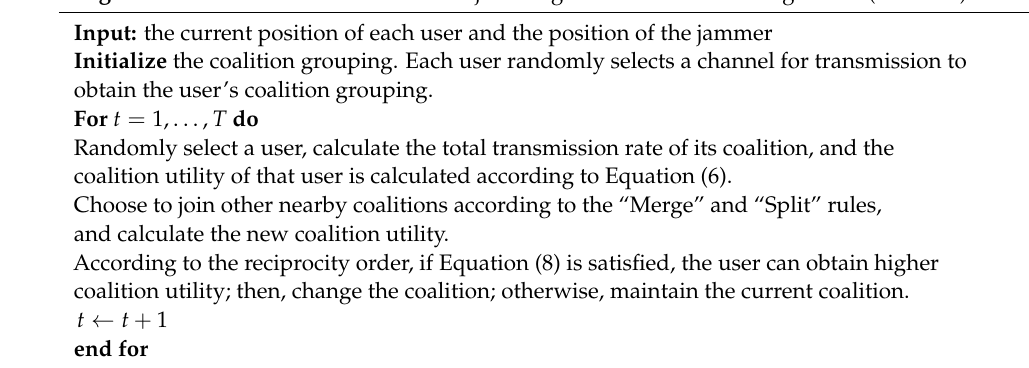
Algorithm 1 Multi-user distributed anti-jamming coalition formation algorithm (MDACF)